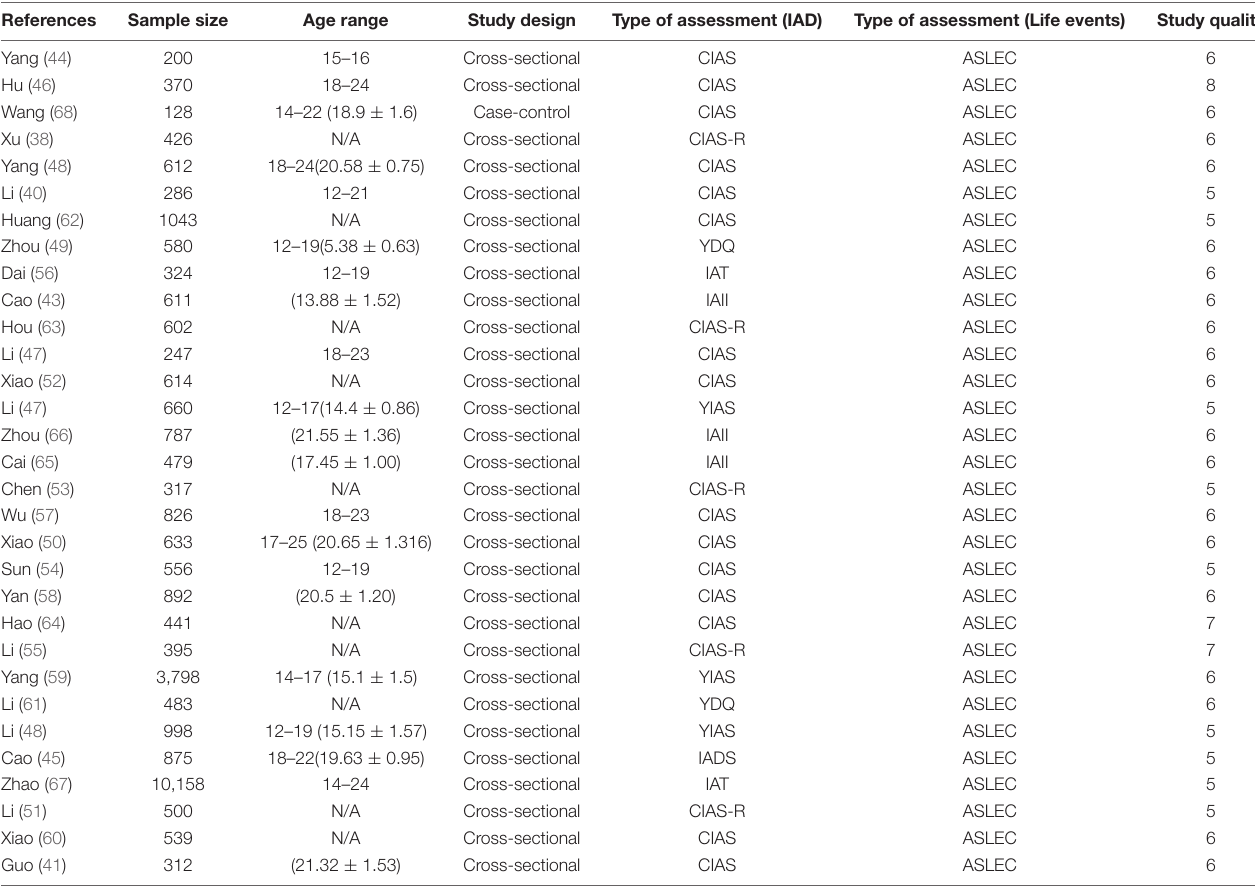
TABLE 1 | Characteristics of the included